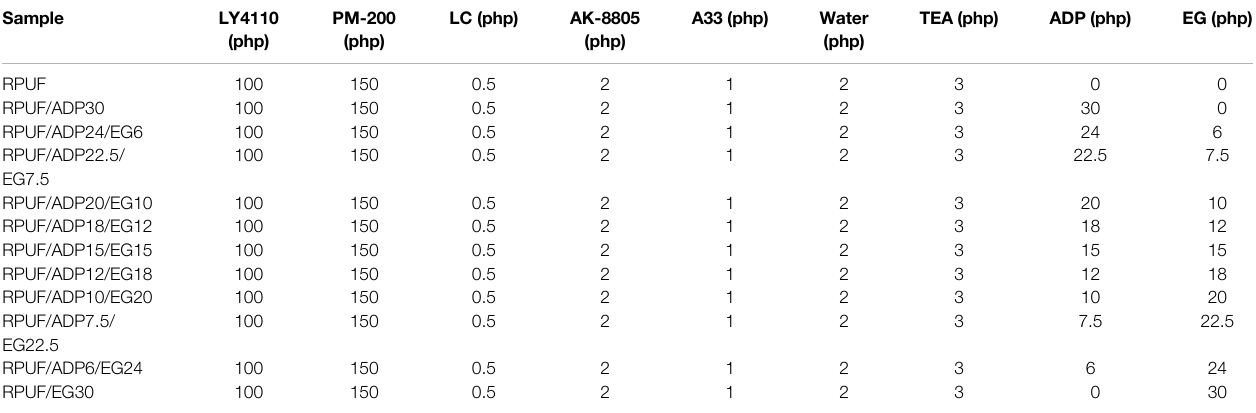
TABLE 1 | Formulation of RPUF and FR-RPUF composites.